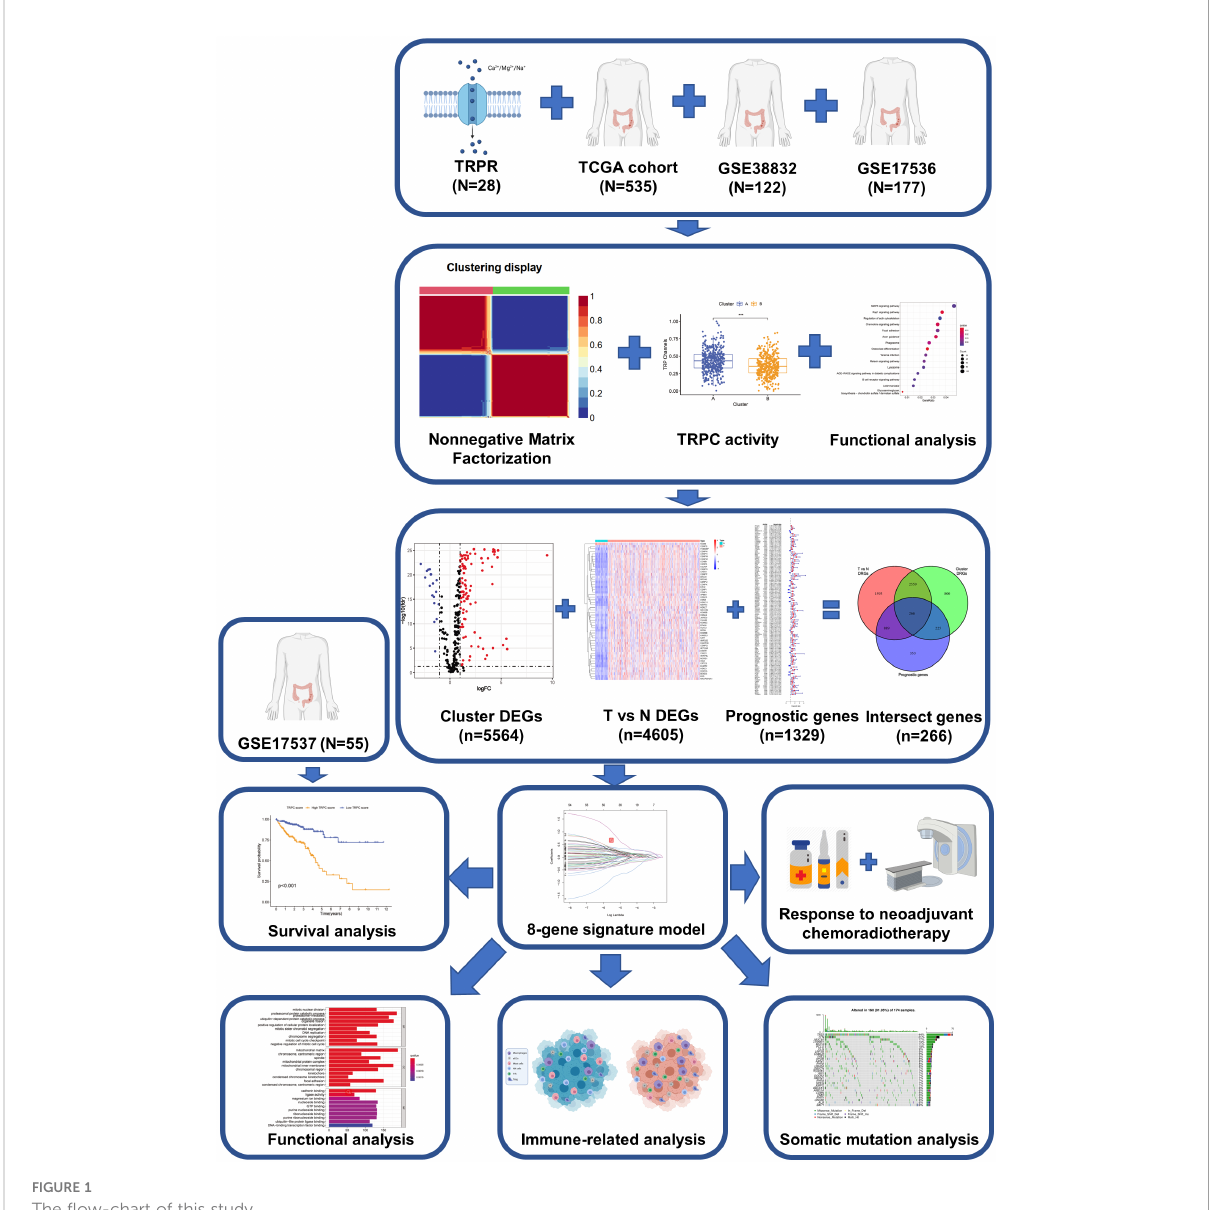
FIGURE 1 The fl ow-chart of this